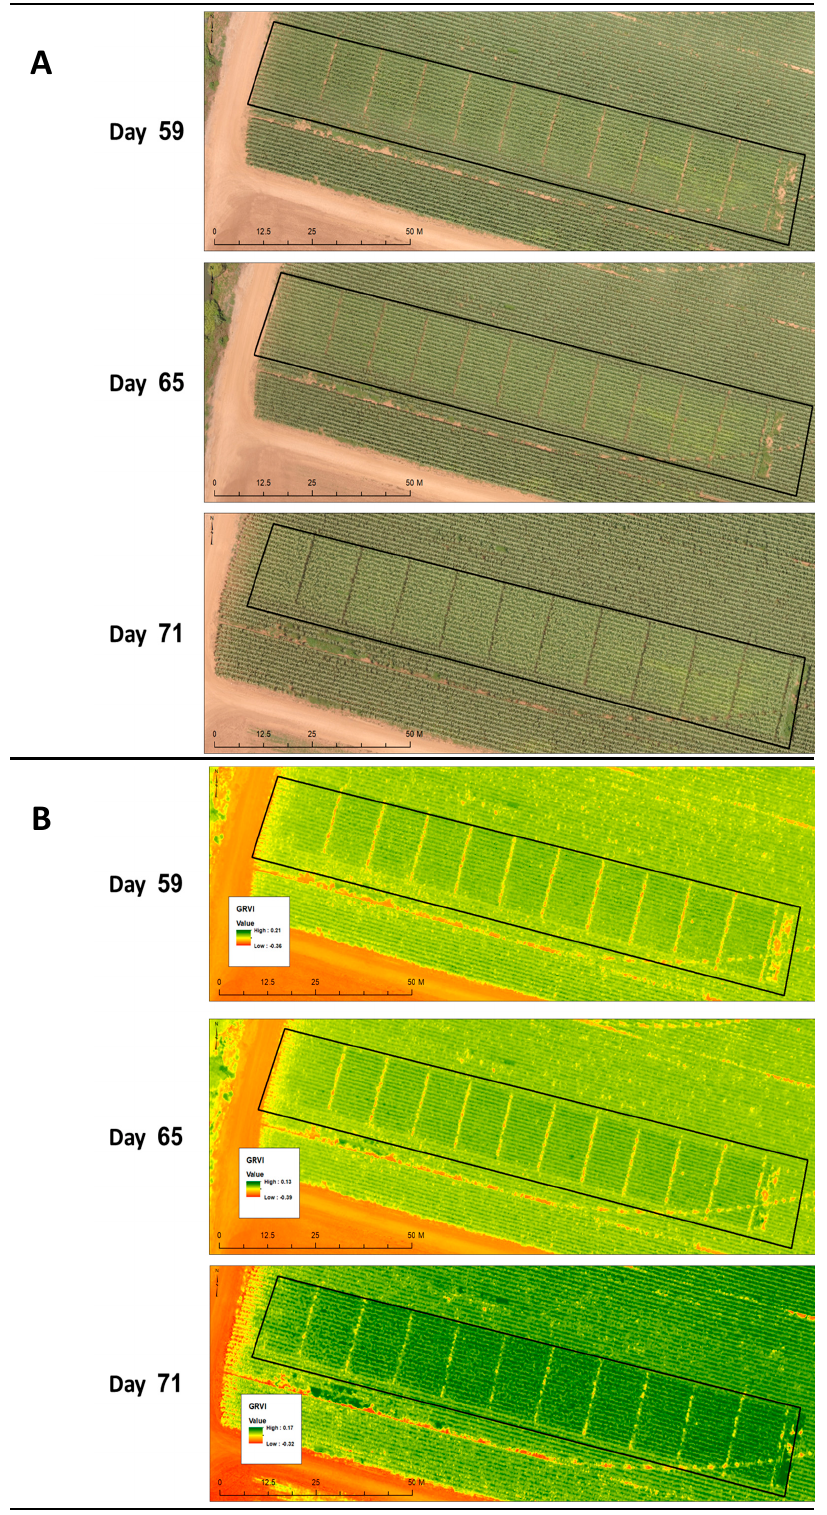
Figure 2. RGB ( A ) and green-red vegetation index (GRVI) ( B ) aerial images of the whole field. The images were taken by a UAV at 59, 65, and 71 DAS (4, 10, and 16 DAF) (Neot Mordechai, spring 2018). Darker green shades in the GRVI image is indicative of a healthy plant while yellow is indicative of a stressed plant, and orange-red indicating